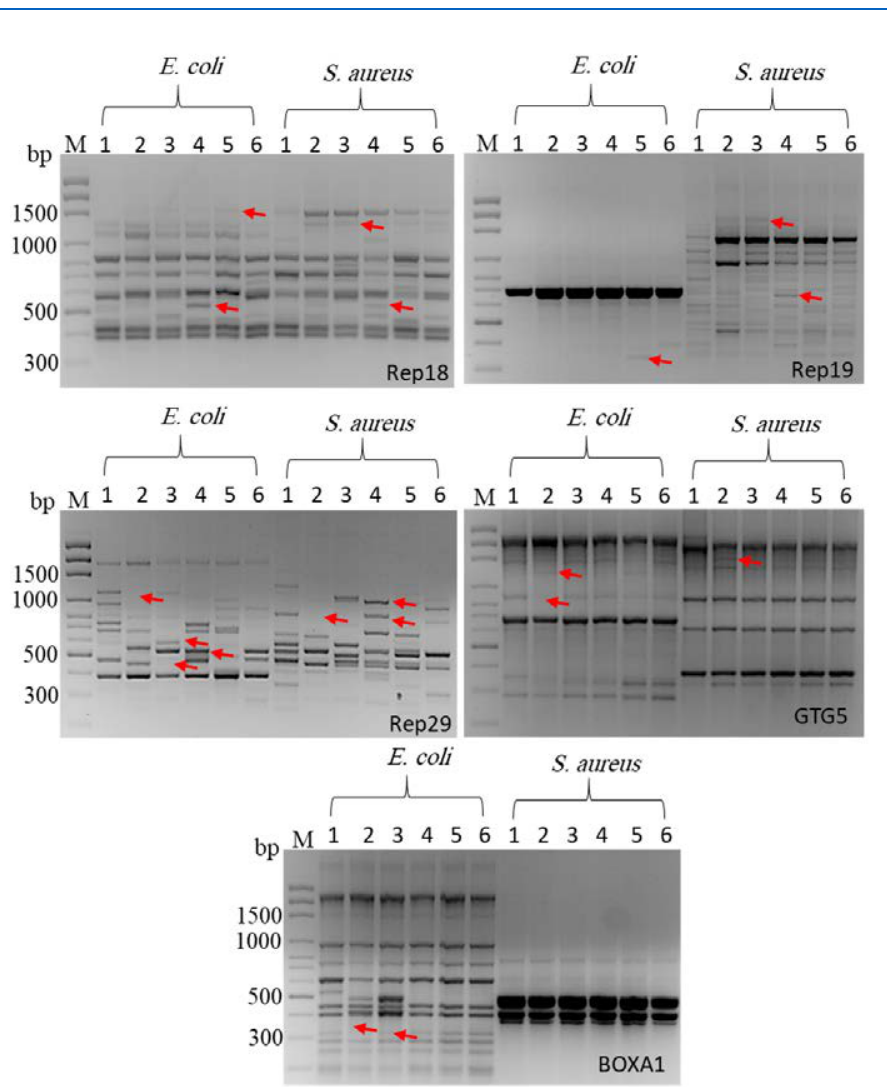
Fig. 3 . Rep-PCR profile of the E. coil and S. aureus treated with five different concentrations of rosemary leaves extracts. 1 = non treated cells, 2 to 6 = 10, 20, 30, 50 and 75 ml dilution of the leaves extract using five Rep-PCR markers. M: is 100 bp DNA